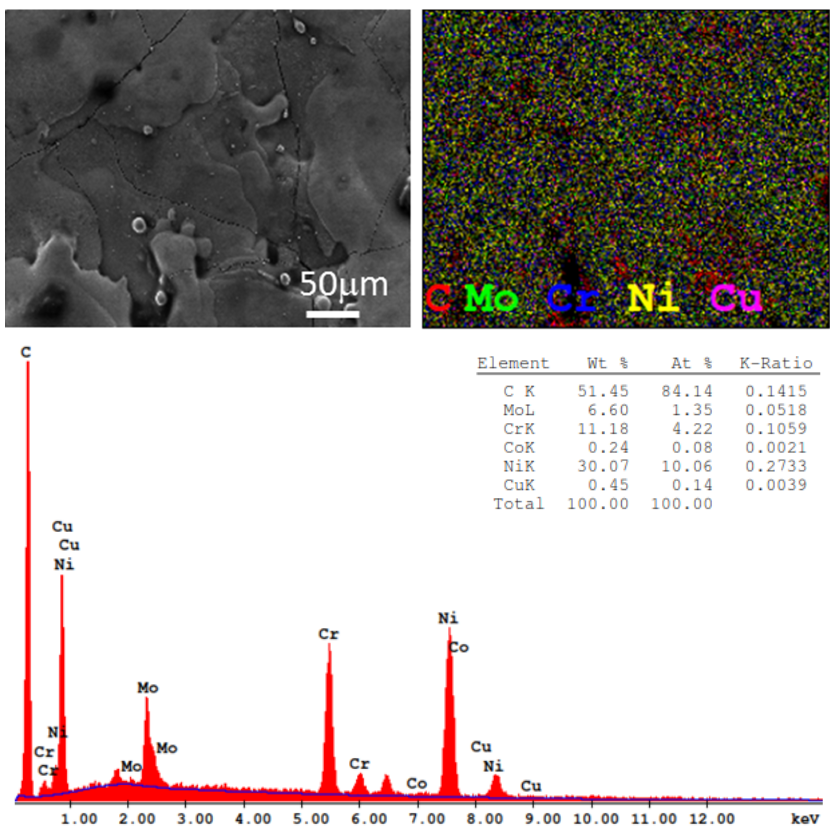
Figure 6. EDX and imaging mapping analysis, UT-500 μ s-6 A.